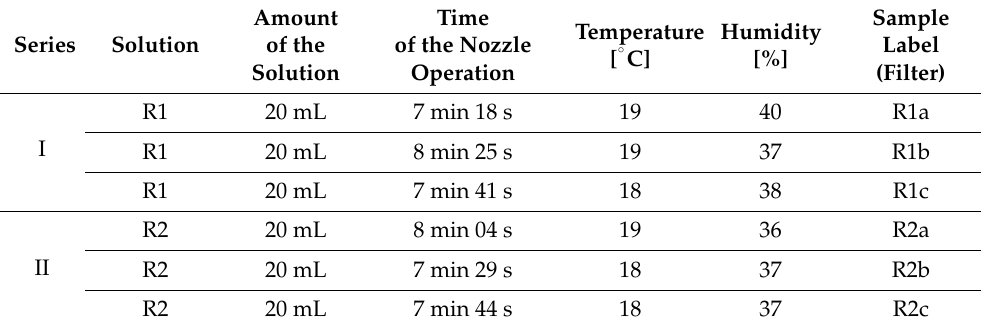
Table 2. The conditions of the experiment.